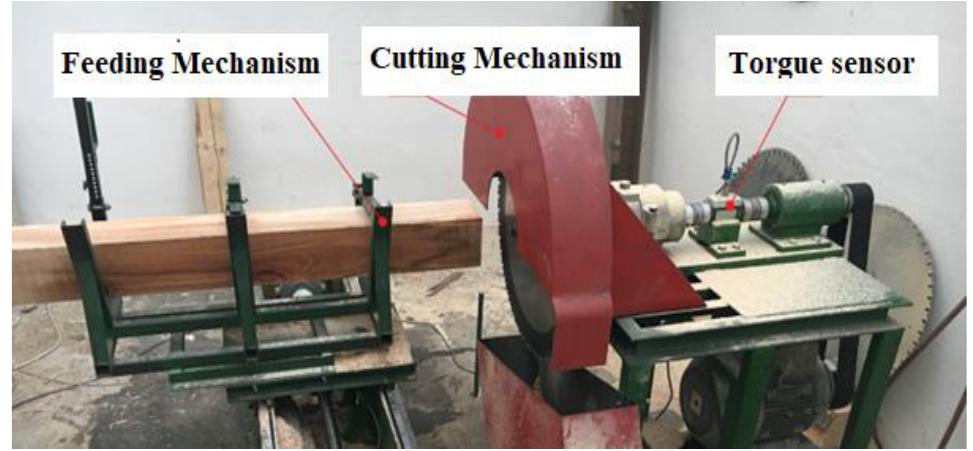
Figure 4. Testing measurement equipment for transverse wood cutting